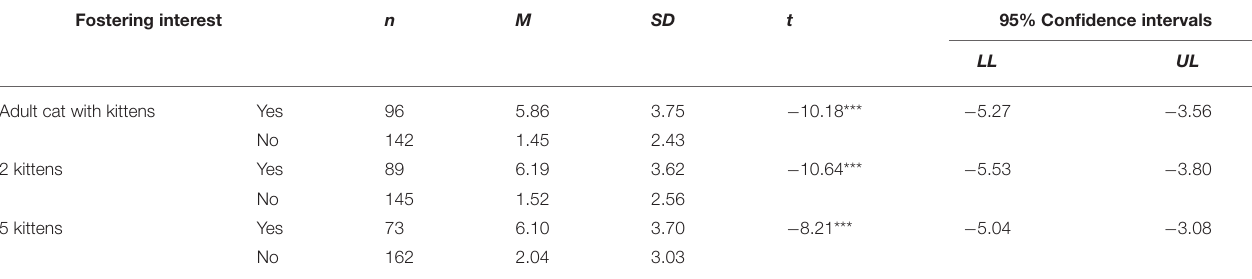
TABLE 5 | Relationship between fostering interest and number of program requirements able to be